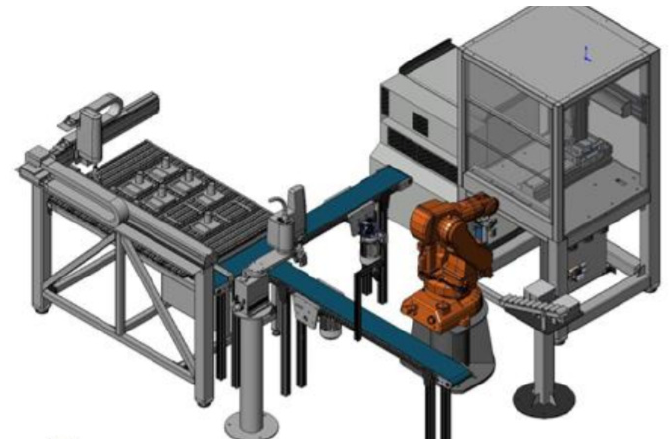
Figure 2. Integrated automated manufacturing system (Source: CIT Automatizari—Actionari electrice inteligente (in Romanian) [52]).